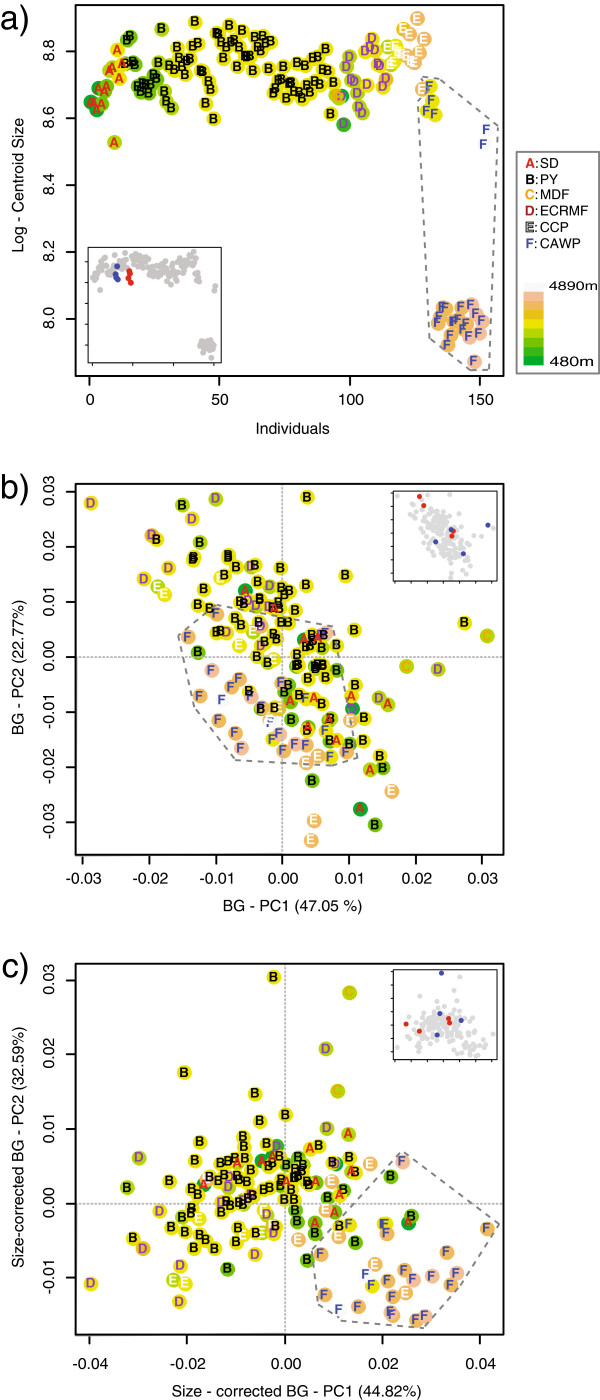
Skull size and shape variability in A. mollis. Scatterplots of all sampled individuals according to their centroid size (a) and their scores on the first two between-groups principal components (BG-PCA) of uncorrected (b) and size-corrected shape (c) (see Methods for details). Individuals from the highest ecosystem (i.e., Central Andean wet puna) are surrounded by a minimum convex hull to facilitate comparison between scatterplots. In addition, in order to illustrate the amount of intrapopulation variance, the position of individuals from two arbitrarily selected populations are highlighted in blue and red (populations 9 and 14, respectively; see Appendix) as an example in an inset in each plot. Symbols are based on two proxies of environmental variation, the elevation and ecosystem (abbreviations as in Figure 1) in which each specimen was sampled.